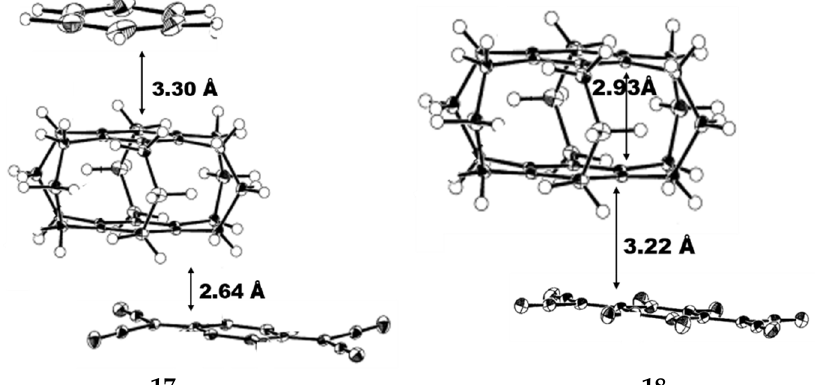
Figure 11. ORTEP drawings of complexes 17 and 18 at − 190 °C (the probability of thermal ellipsoid is 50%).